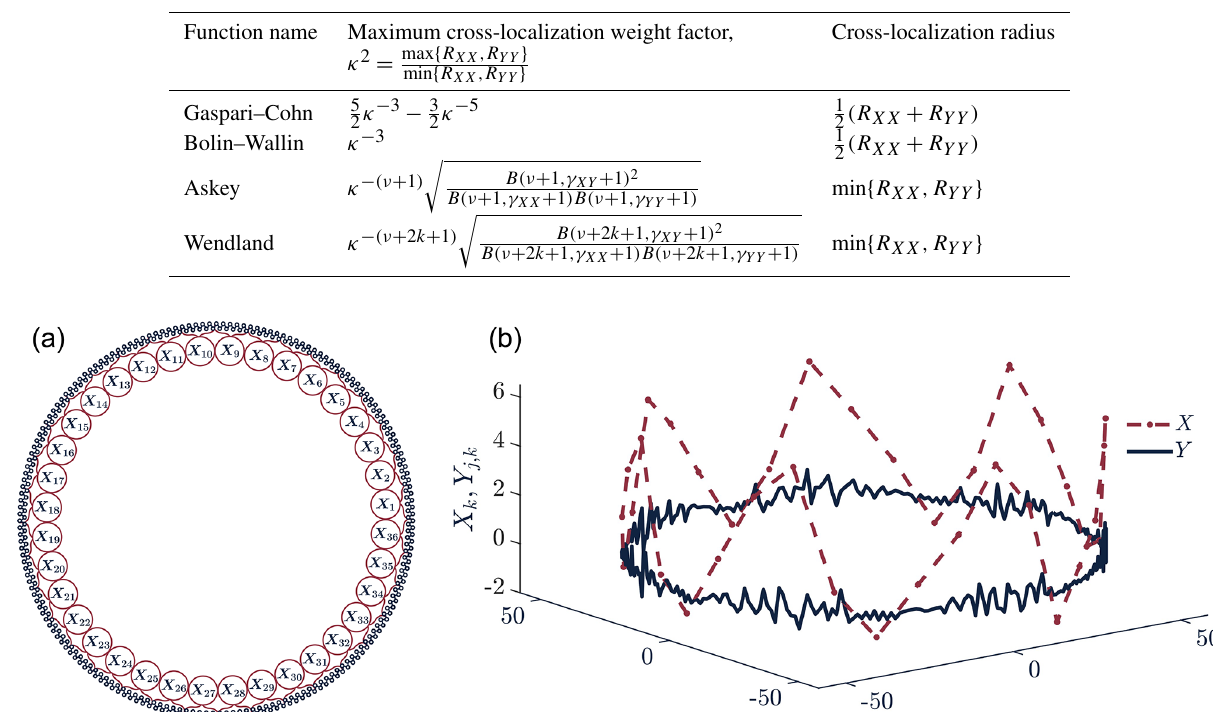
Figure 2. (a) Schematic illustrating the location of the different variables in the bivariate Lorenz 96 model, inspired by Wilks (2005). The setup has K = 36 sectors, with J = 10 small process variables per sector. The large process is shown on the inner circle, and each X variable is labeled. The small process is shown, unlabeled, in the outer circle. Curly brackets show the sectors. (b) A single snapshot of the bivariate Lorenz 96 model with variables placed on a circle. The large process X (red; dashed) has fluctuations with amplitude about 10 times larger than the fluctuation of the small process Y (dark;